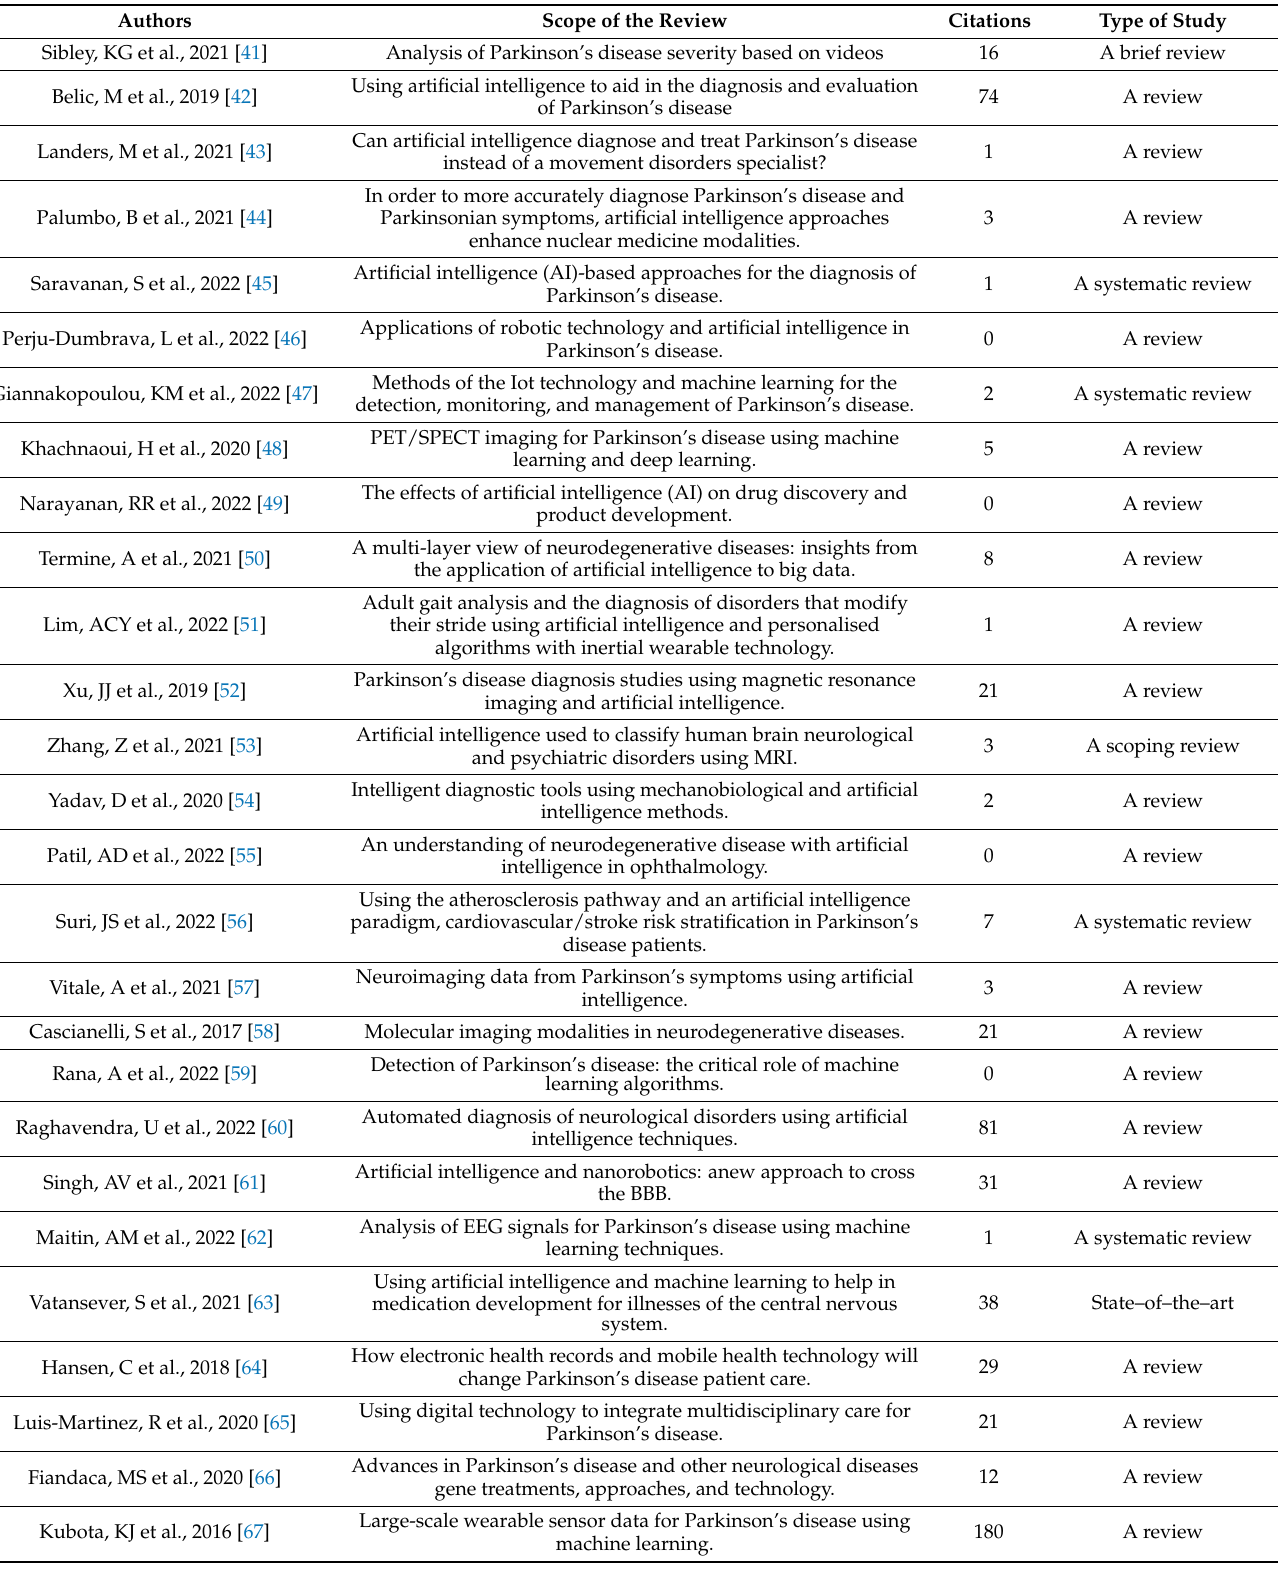
Table 2. Summary of review article to diagnose PD (2015–2022) from Web of Science